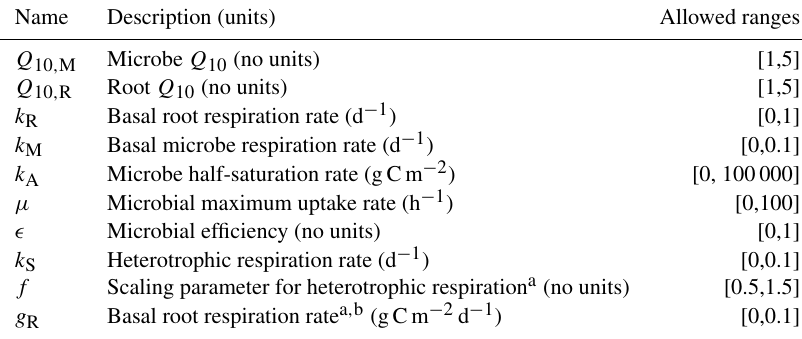
Table 2. Description of parameters used for the FireResp model along with the allowed